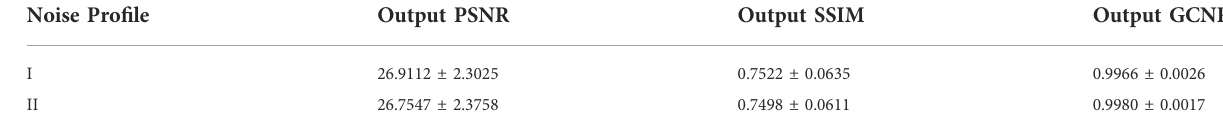
TABLE 4 PSNR, SSIM, and GCNR result for the ablation study on the effect of different resolution pro fi les on the model performance. (Noise Pro fi le I (Rayleigh noise variance = 0.2, Gaussian fi lter standard deviation = 0.8). Noise Pro fi le II (Rayleigh noise variance = 0.1, Gaussian fi lter standard deviation = 0.7). Input PSNR = 26.0071 ± 2.3083, Input SSIM = 0.7098 ± 0.0761, Input GCNR = 0.9936 ±